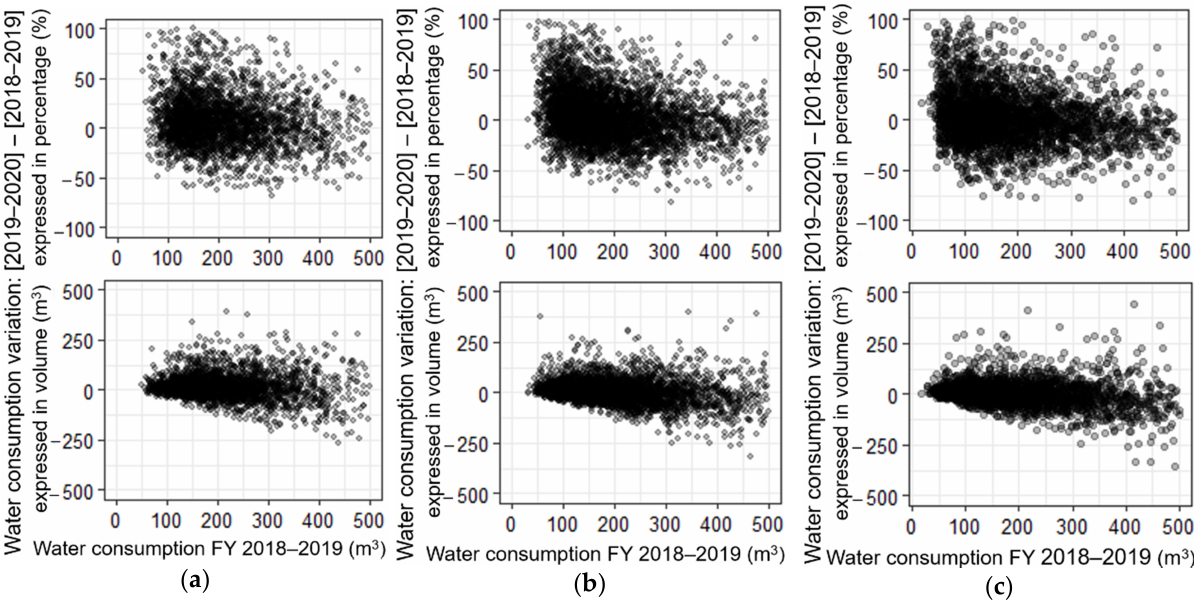
Figure 6. Water consumption variation among customers in percentage and volume terms: ( a ) Birat, ( b ) Lekhnath, and ( c ) Kakarvitta.